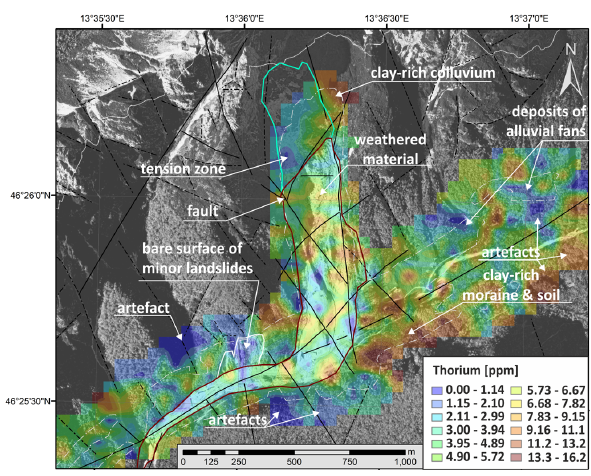
Fig. 8. Gamma ray survey: a map of Uranium combined with the fault and joint pattern (black full and dot-and-dashed lines), area of reliable data (light grey dot-and-dashed line) and the geological interpretation; the units are parts per million [ppm] (Source of data: Geological Survey of Austria and Google Earth).